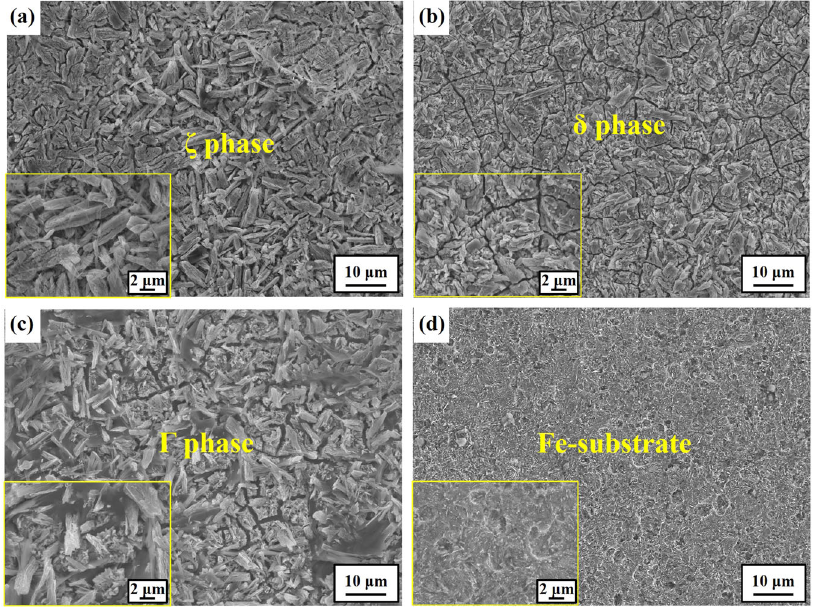
Fig. 6 Surface morphologies of GA sample during electrochemical stripping test in a 3.4 M NaCl + 0.3 M ZnSO 4 solution. a – d FE-SEM observations at respective potential steps marked on Fig.